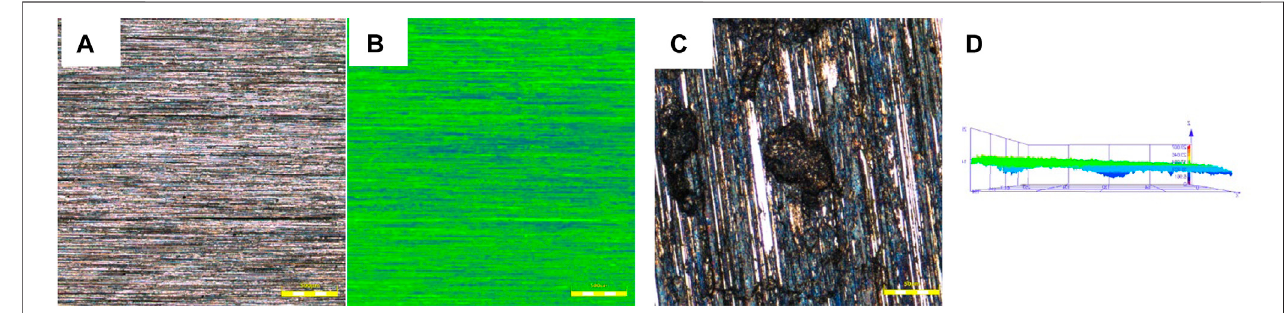
FIGURE 3 | Micro-morphology of 825 sample after removal of the corrosion products at different temperatures: (A , B) no pit founded at 150 ° C. (C , D) black pits founded at 230 ° C and scanned by CLM.